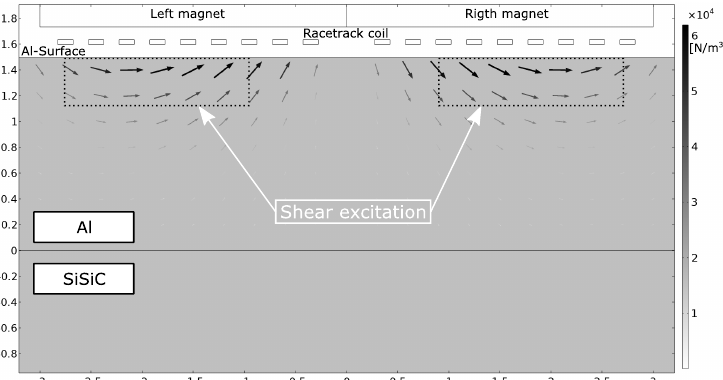
Figure 8. Simulated Lorentz forces based on Equation (1). Directly below the left and right magnet, Lorentz forces parallel to the aluminum surface are generated with the highest magnitude and the same direction. Beneath the center of the racetrack coil, the forces point in opposite directions and are normal to the surface. The forces penetrate about 0.5mm deep into the aluminum. Below the middle of the racetrack coil, the forces vanish as no eddy currents are generated in this area.